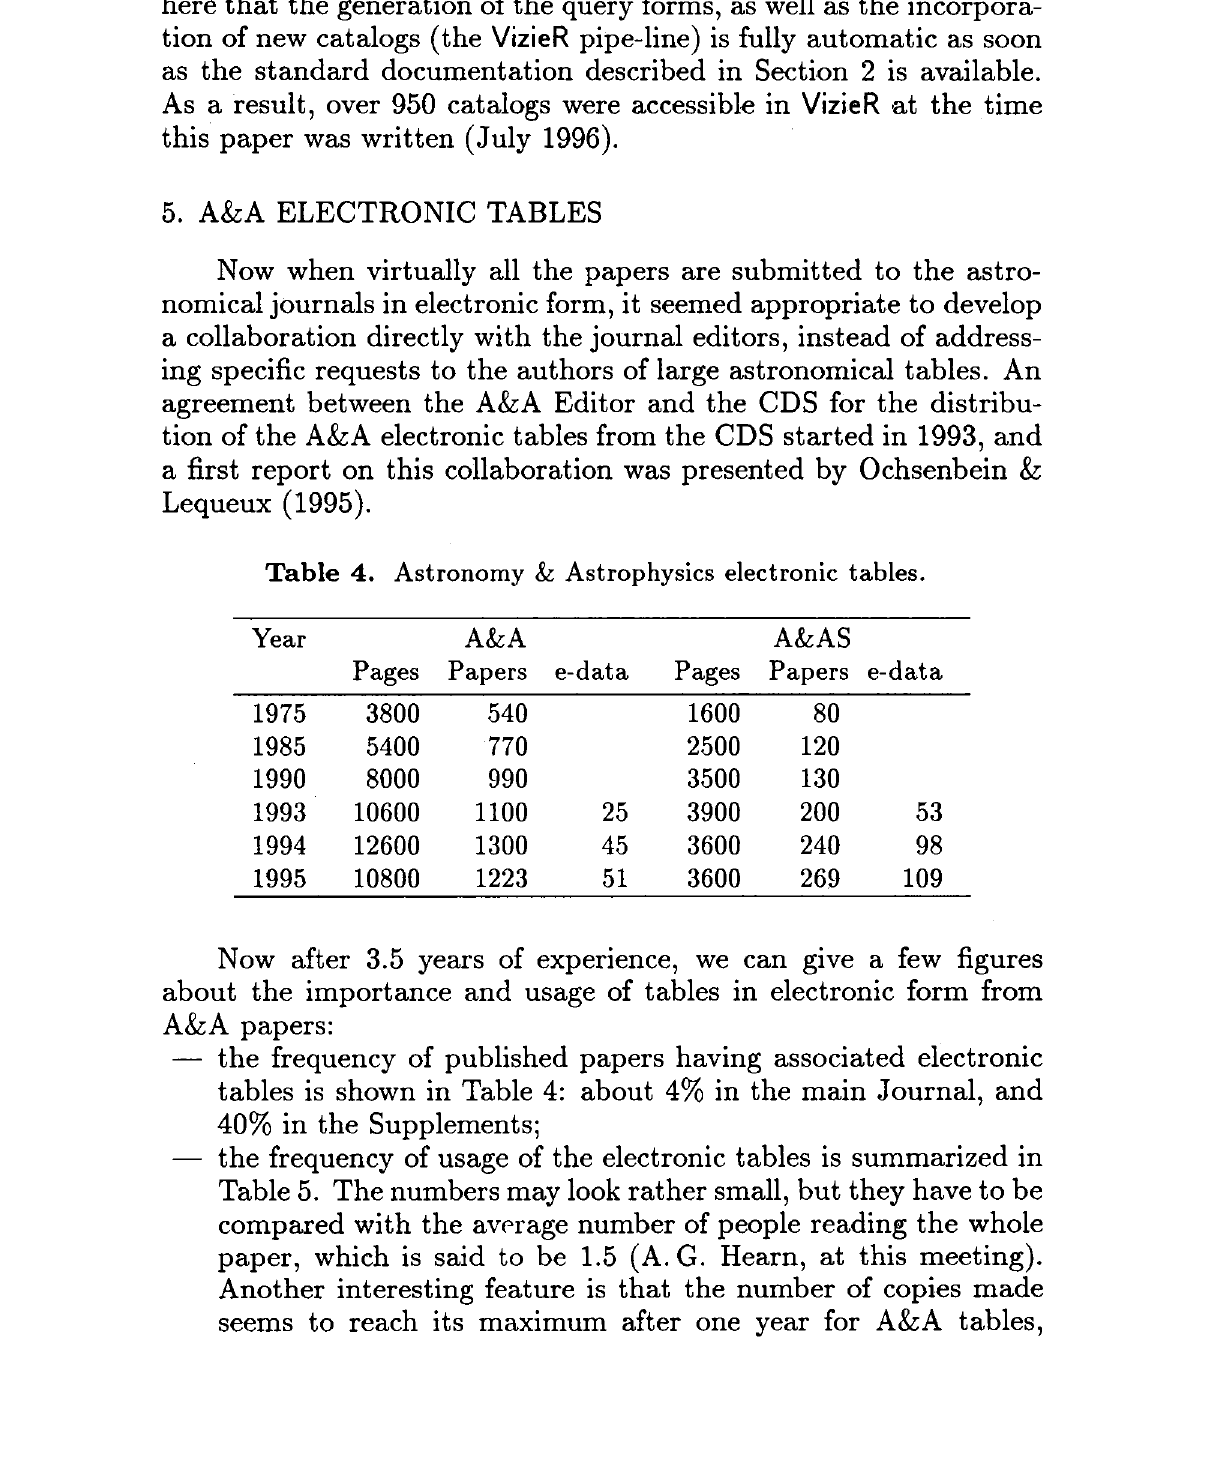
Table 4. Astronomy L· Astrophysics electronic